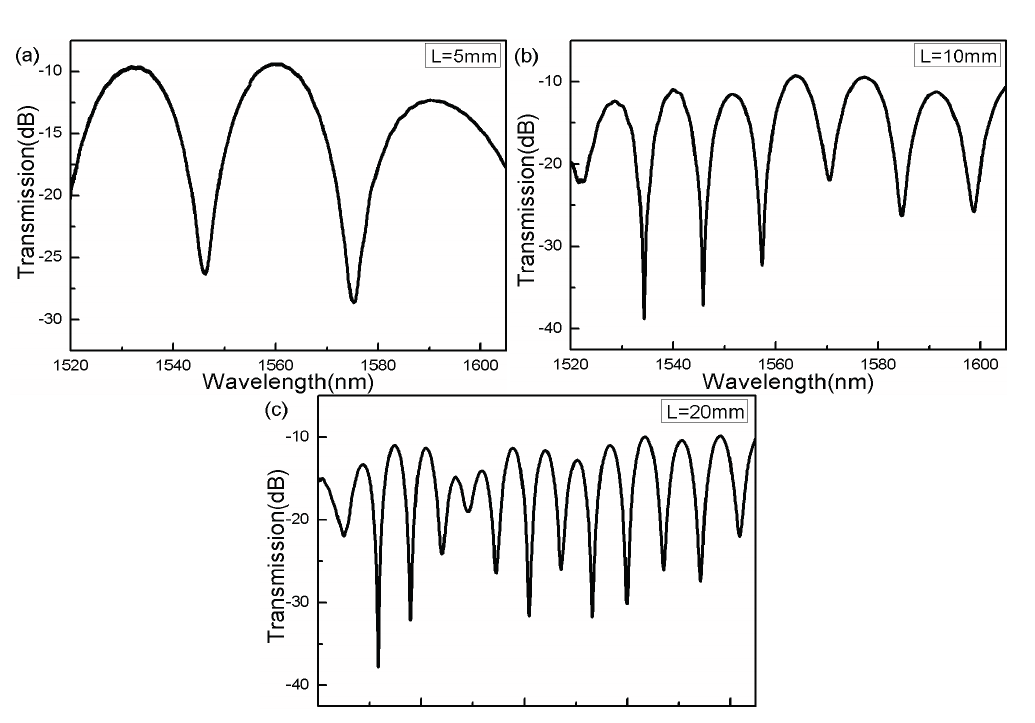
Figure 2. Transmission spectra of MMF-TCF-MMF configuration with different TCF